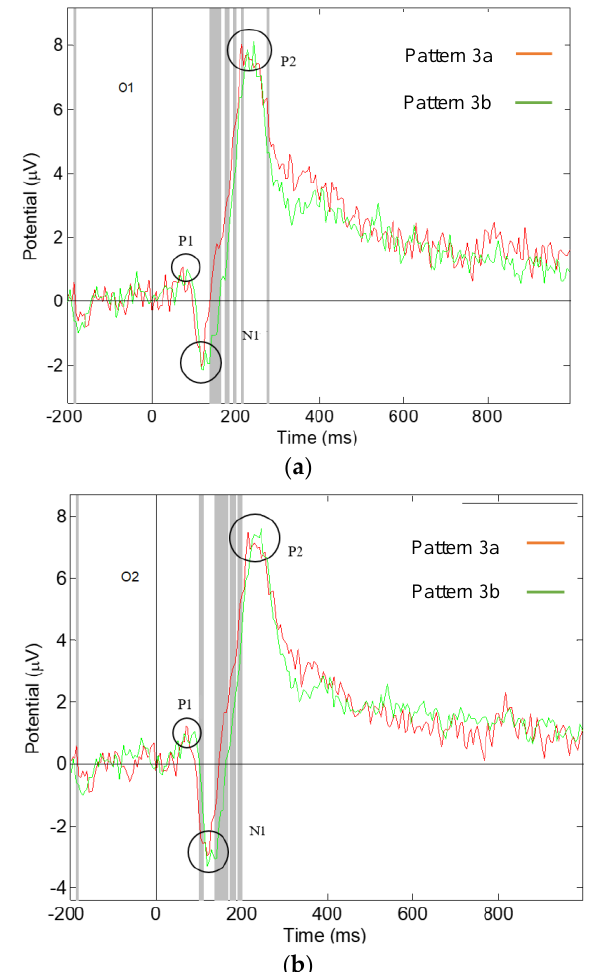
Figure 11. Grand average ERP responding to Pattern 3a,b, the grey lines show the significant difference with p -value < 0.05: ( a ) measured at O1 electrode channel; ( b ) measured at O2 electrode channel. Table 3. Amplitude and latency differences of N and P components of visual ERP waves evoked by Pattern 3a,b